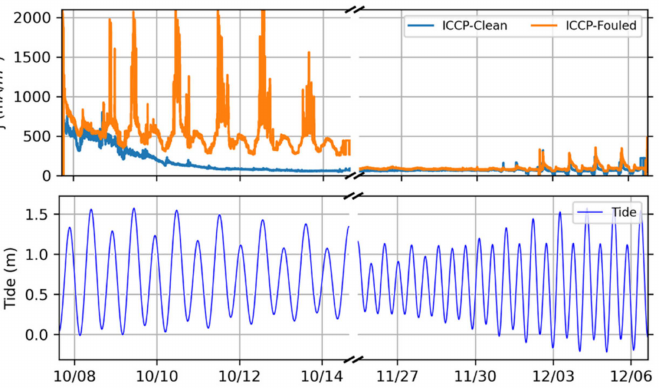
Figure 7. ICCP current density comparison: Clean vs. previously fouled and corroded ( top ) and tide ( bottom